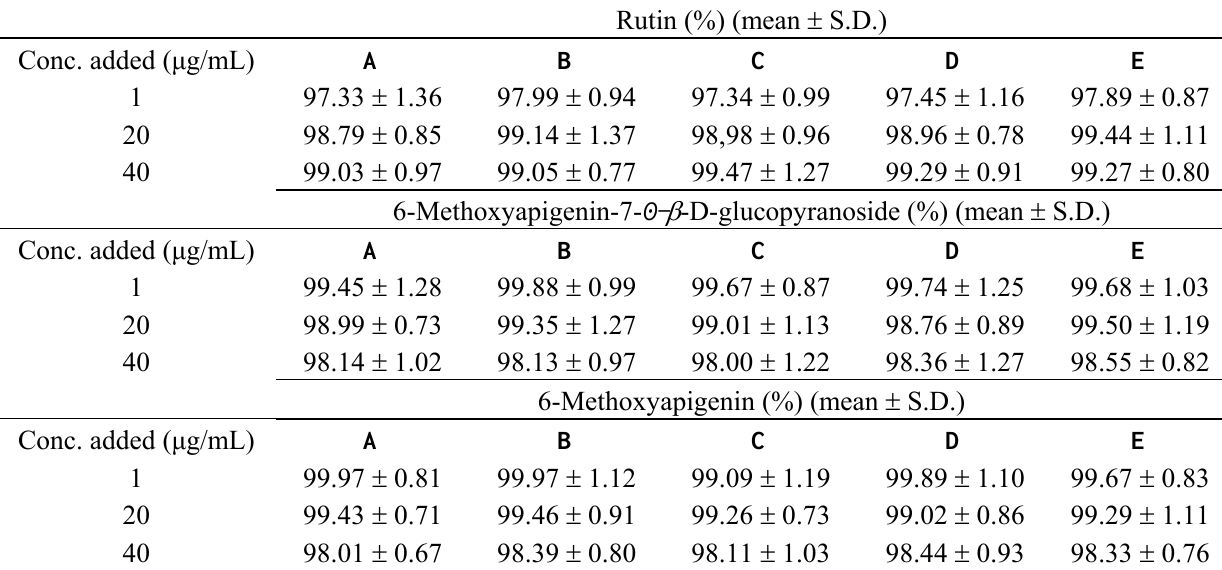
Table 2. Recovery of the flavonoids in samples A - E * (n = 5). Rutin (%) (mean ± S.D.)